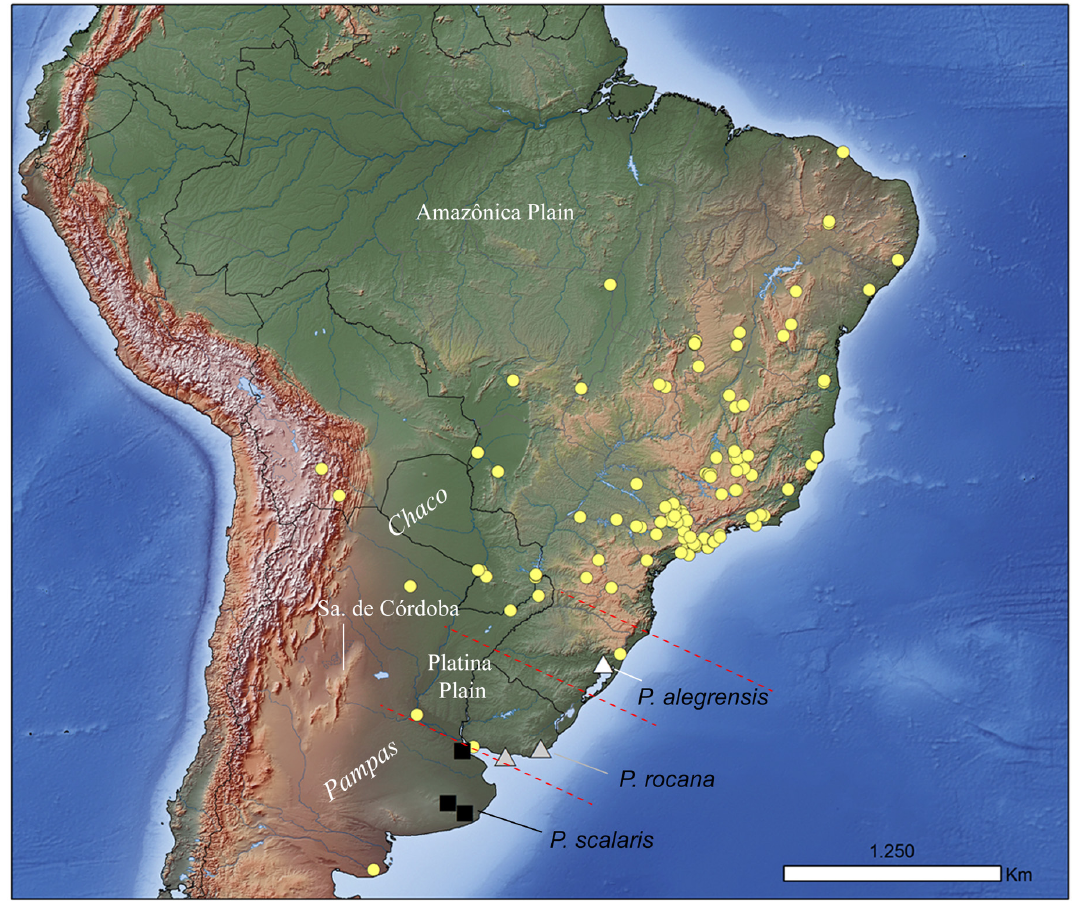
Fig. 15. Biogeographic history of the genus Pseudonannolene Silvestri, 1895. The symbols refer to the distribution data of P. scalaris Brölemann, 1902 (black squares), P. rocana Silvestri, 1902 (grey triangles), P. alegrensis Silvestri, 1897 (white triangle), and remaining species (yellow